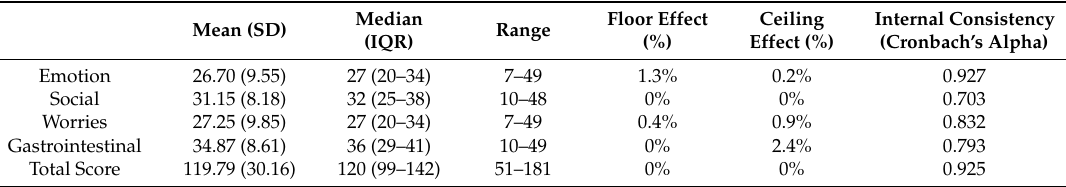
Table 1. Descriptive and internal consistency of the Brazilian CD-QoL.